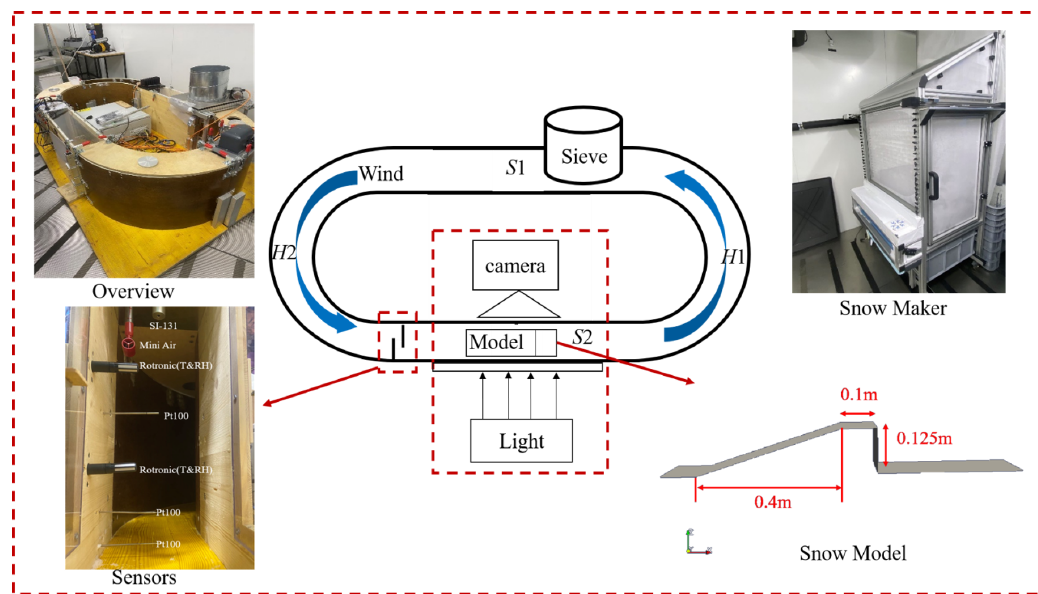
Figure 1. Schematic diagram of the closed-circuit tunnel experimental system in the cold lab. The insets are the pictures of the RWT, snow maker, sensors and the snow model setup inside the